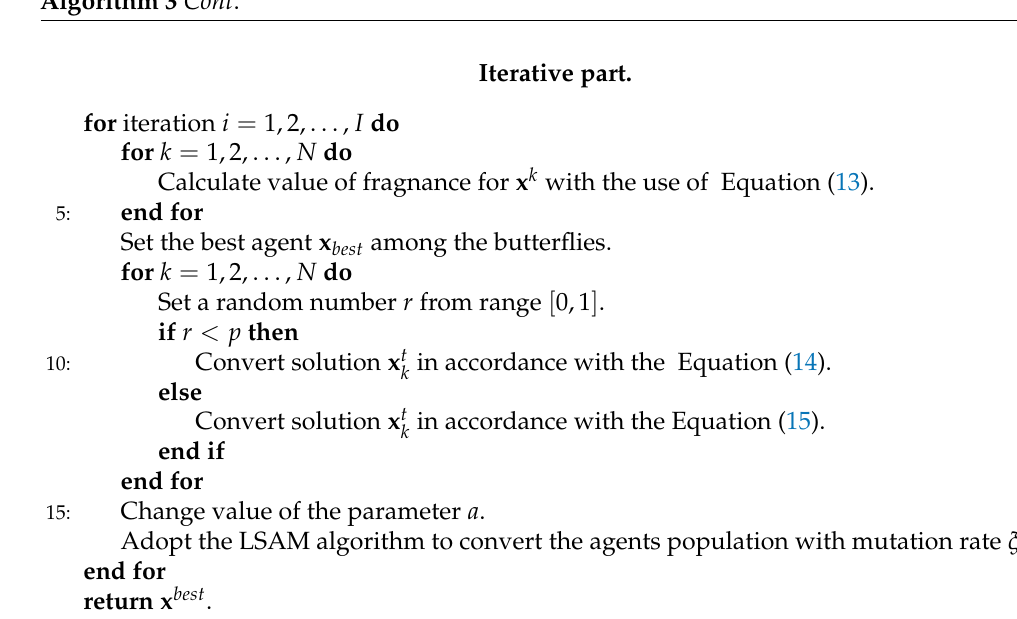
Algorithm 3 Cont .